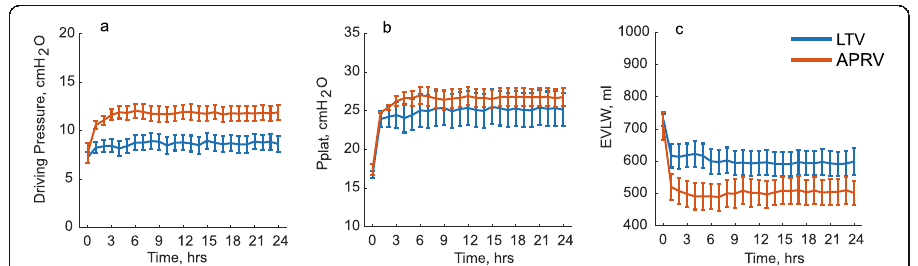
Fig. 4 Graphical results for hourly changes in key indices of ventilator-induced lung injury: a driving pressures, b plateau pressures (P plat ), and c extravascular lung water (EVLW). The LTV arm is represented in blue and the APRV arm is in